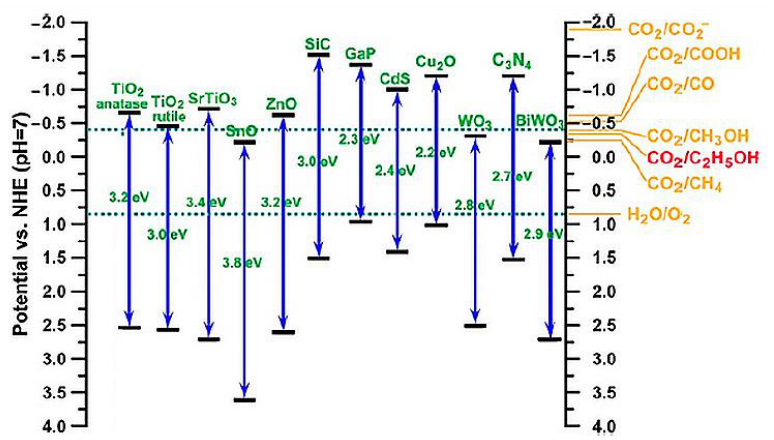
Figure 1. Band structure of several typical semiconductors with respect to CO 2 reduction potentials towards different products at pH = 7. Reproduced with permission from reference [33].